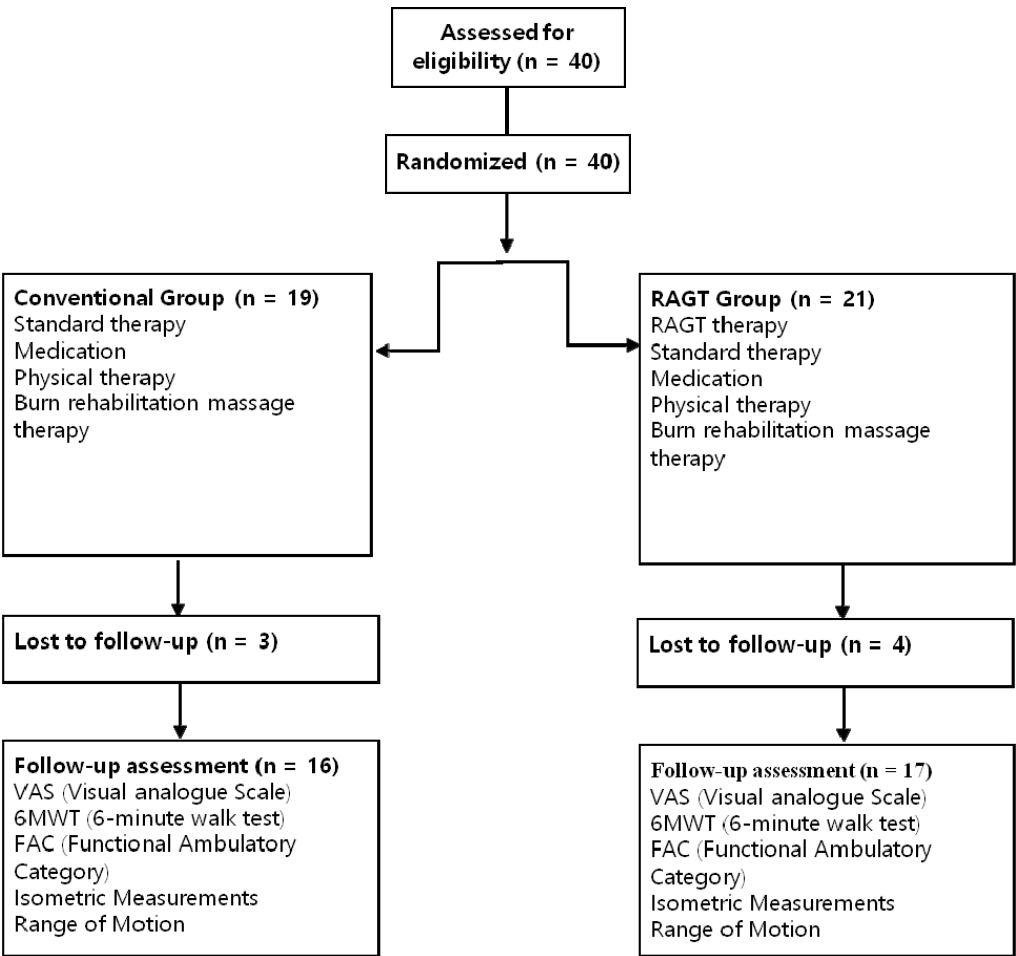
Figure 1. Consolidated standard of reporting trials flow diagram. Table 1. Patients’ demographic data.